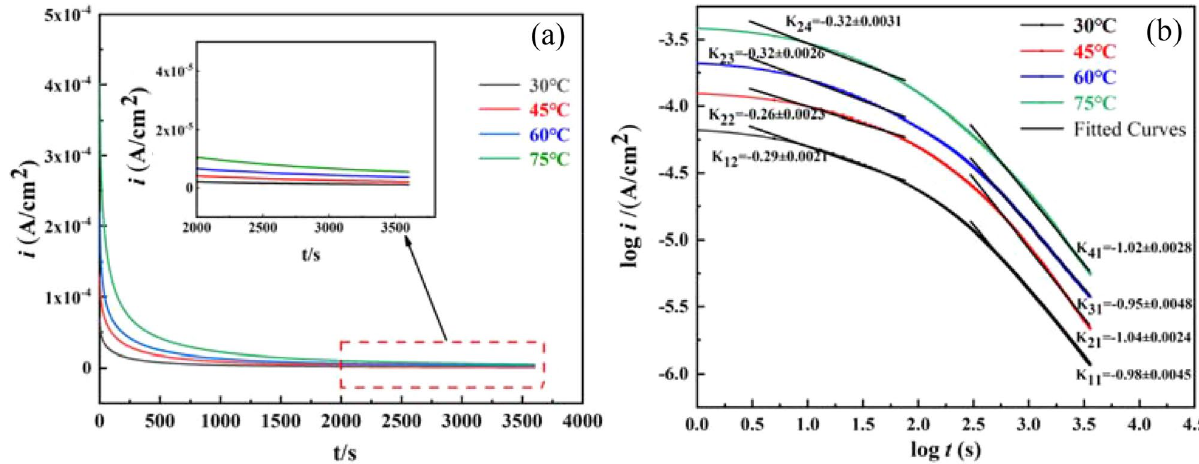
Figure 5. Constant potential polarization curves of 2205 DSS at the same film formation potential vs different temperatures. ( a ) Current density versus time, ( b ) log i - log t for passivation film